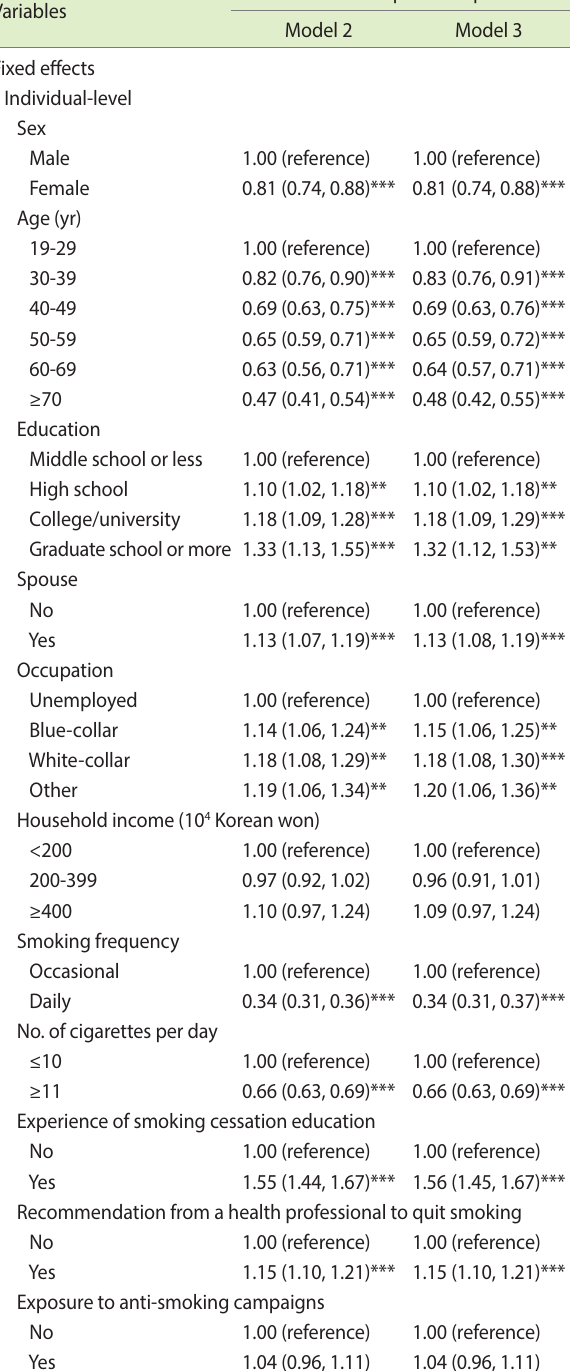
Table 2. Descriptive statistics for community-level variables Variables